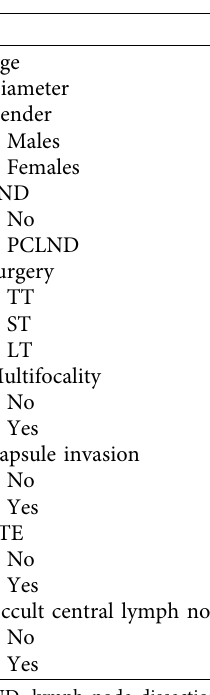
Table 1: Baseline characteristics of patients ( N �